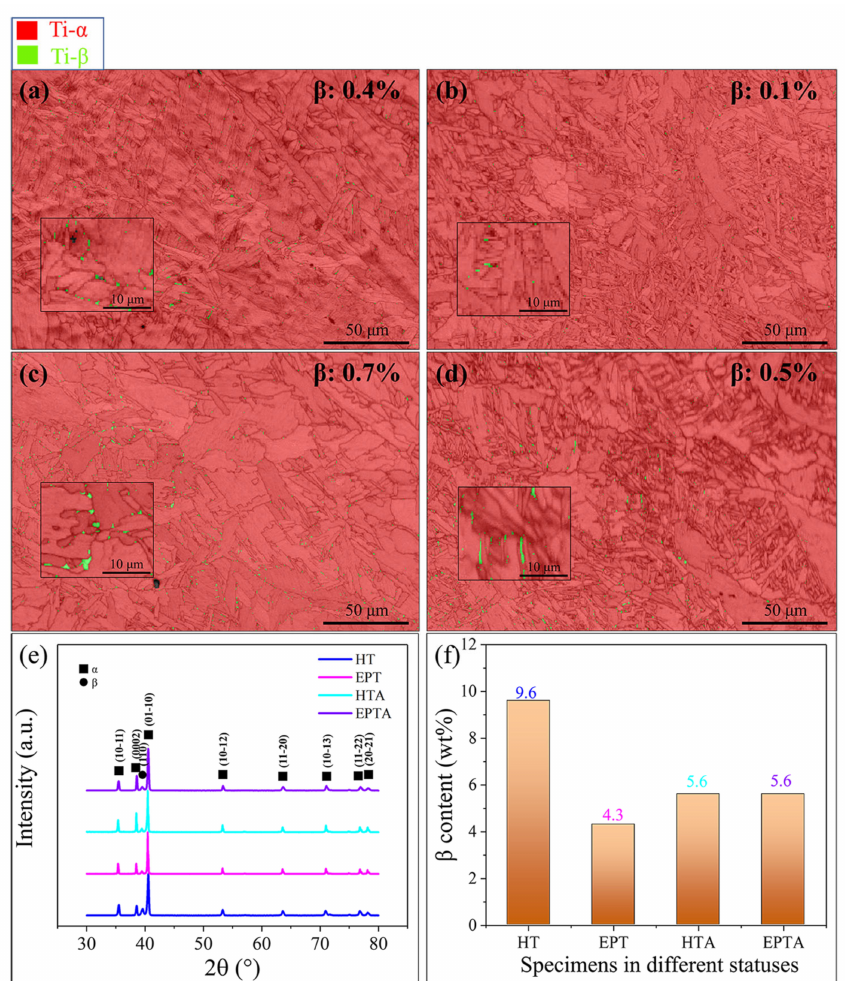
Figure 4. Phase maps: ( a ) HT, ( b ) EPT, ( c ) HTA, ( d ) EPTA; ( e ) XRD patterns and ( f ) β -contents calculated by RIR